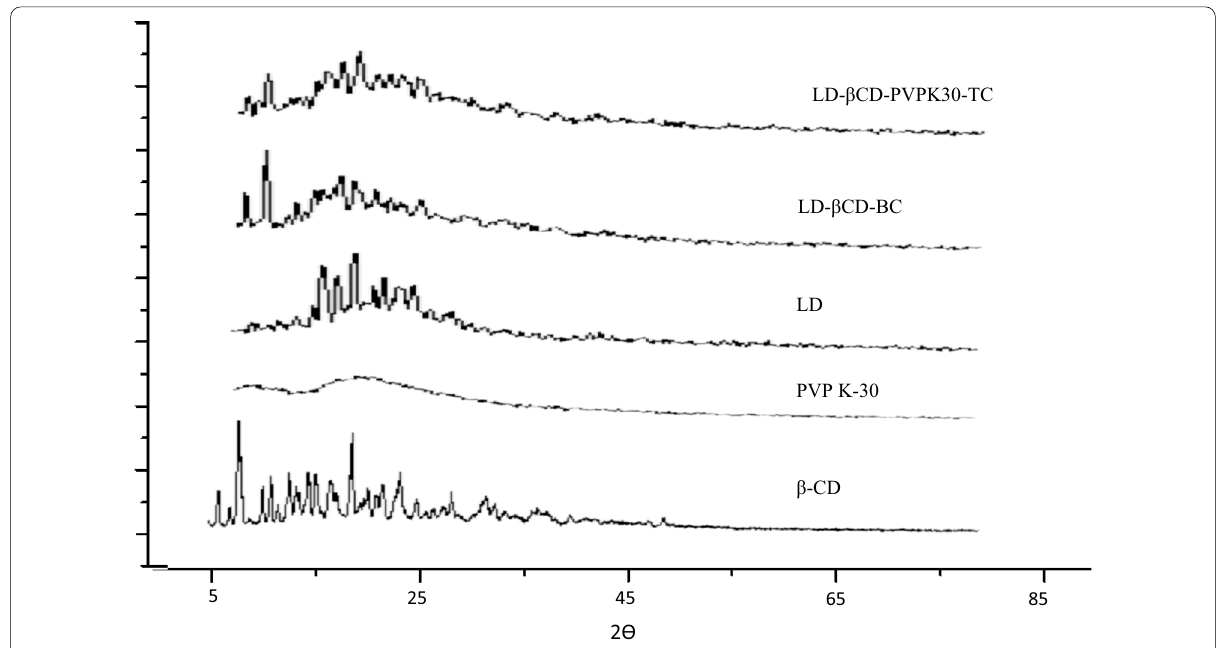
Fig. 9 The X-ray diffractograms of β-CD, PVP K30, binary complex (LD-βCD-BC) and ternary complex